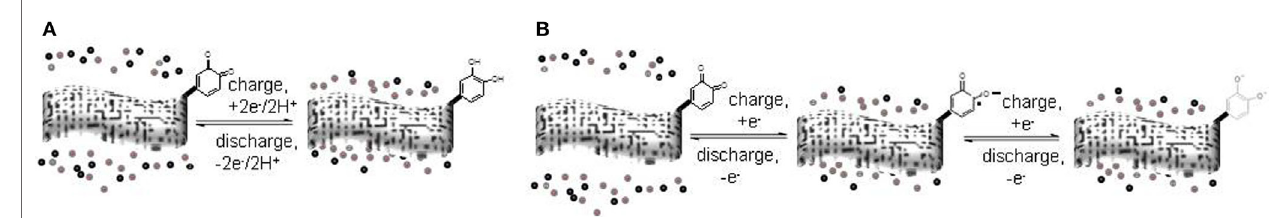
FiGUre 1 | schematics of the charge and discharge electrochemical reactions of quinone-functionalized carbons in (A) aqueous and (B) non- aqueous electrolytes